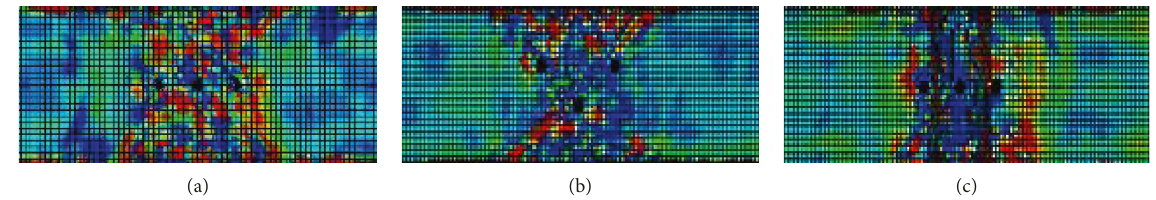
Figure 13: Mises stress nephogram of roof section in the next 0.15ms after blasting. (a) “Straight-line” blasting layout. (b) “Triangle-fractal” blasting layout. (c) “Deep-shallow-fractal” blasting